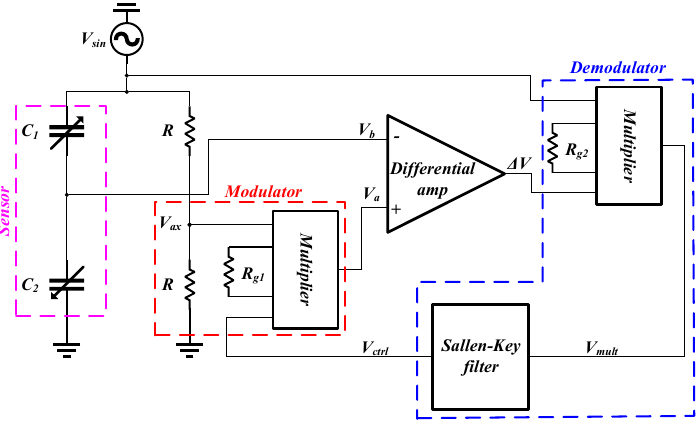
Figure 2. The block scheme of the proposed readout